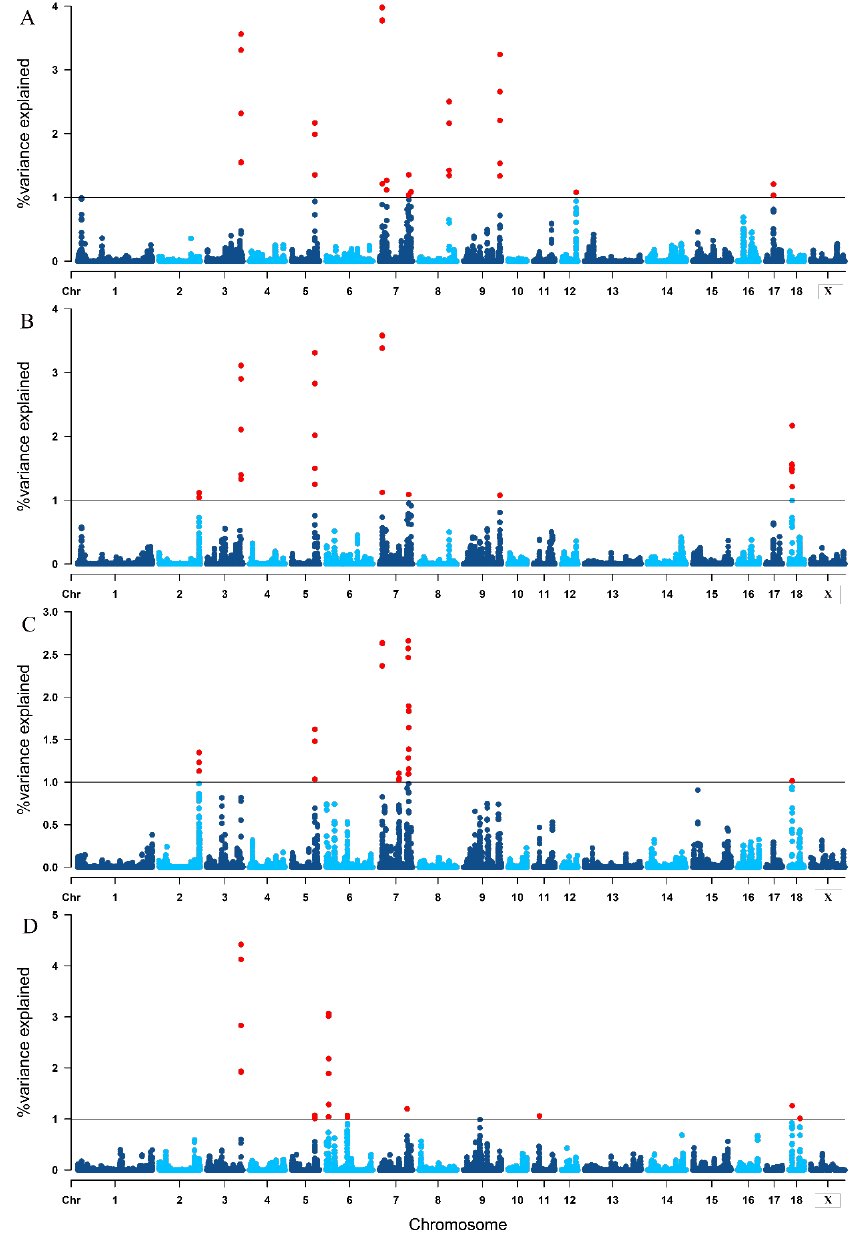
Figure 2. The Manhattan plots of single-step genome-wide association study for four reproductive traits. ( A ) TNB: total number born; ( B ) NBA: number born alive; ( C ) NHP, number healthy piglets; ( D ) LWB: litter weight born alive. Each dot represents one window of 10 adjacent SNPs. The y-axis displays the proportion of genetic variances of each window. The x-axis represents the position of windows for chromosomes. The horizontal solid line depicts the significance level (proportion of genetic variances = 1%).